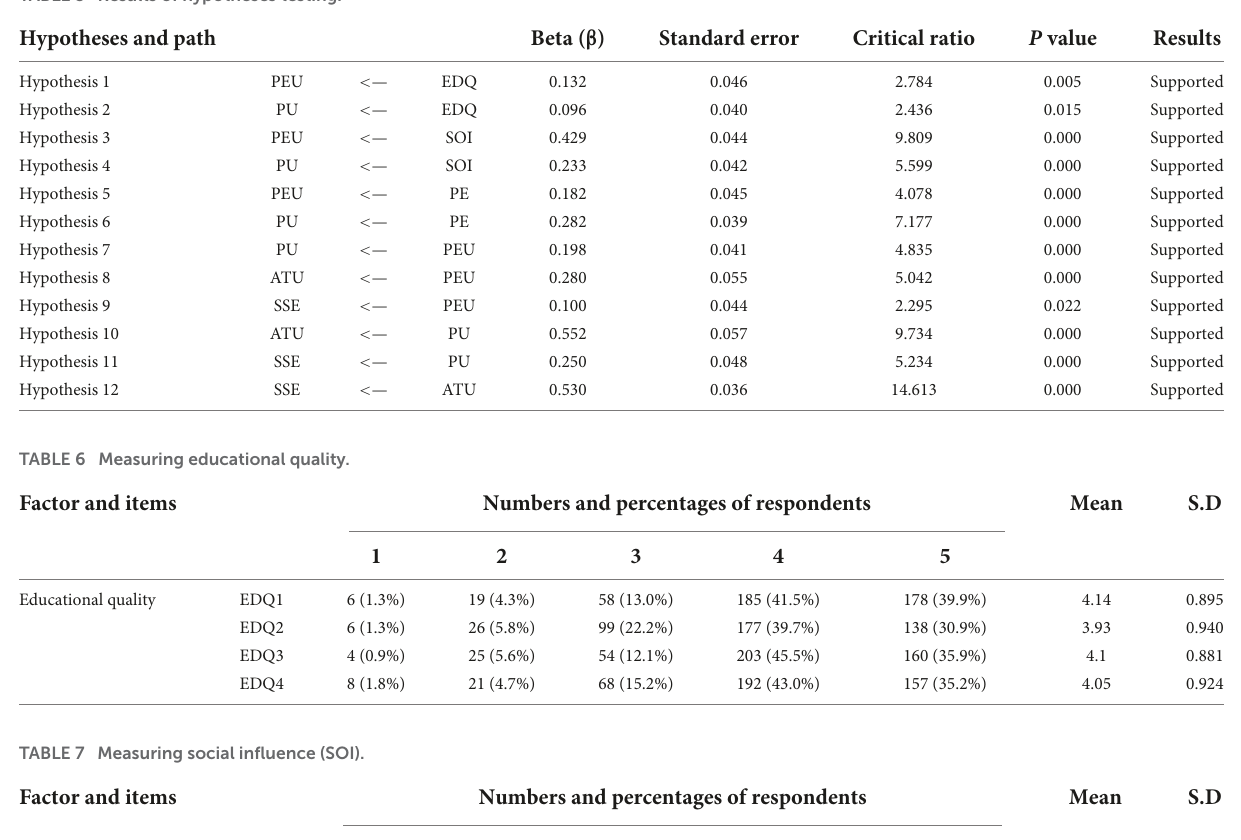
TABLE 5 Results of hypotheses testing.